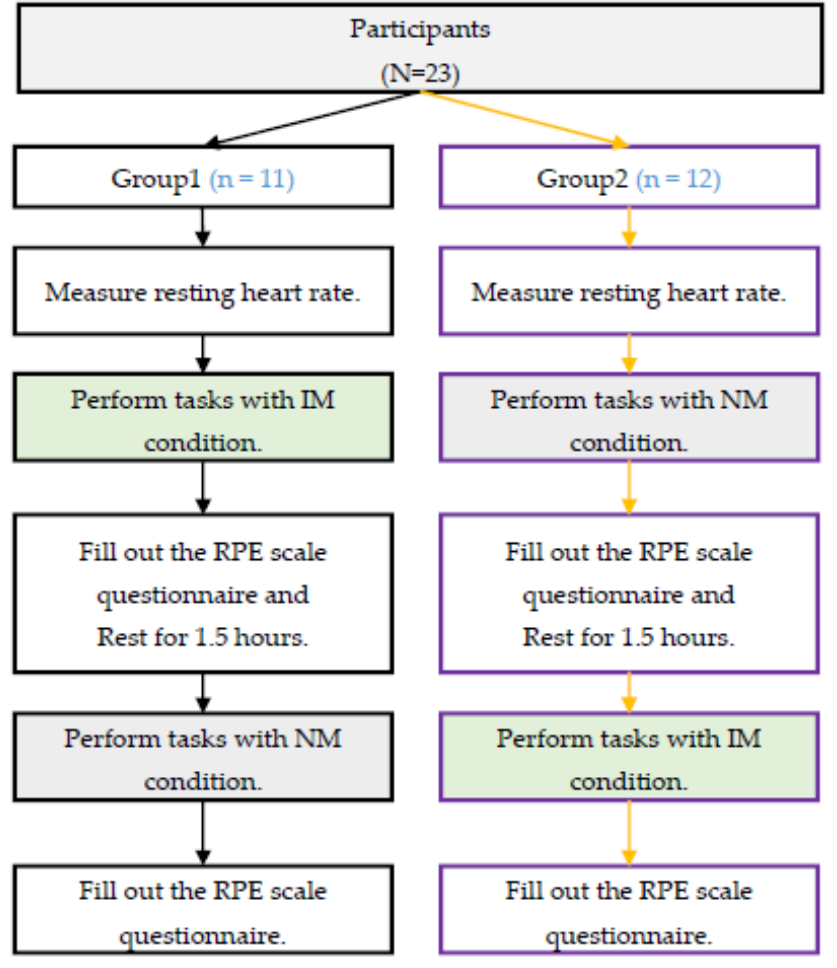
Figure 1. Counterbalanced Design.